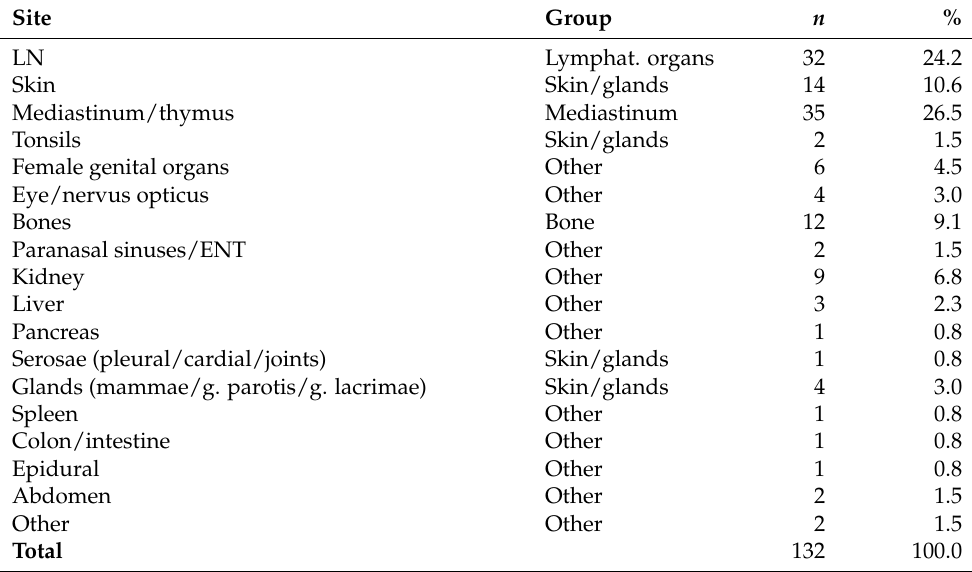
Legend to Table 1: ENT, ear nose throat; LN, lymph node; OEM, other extramedullary. Table 2. Patient characteristics.